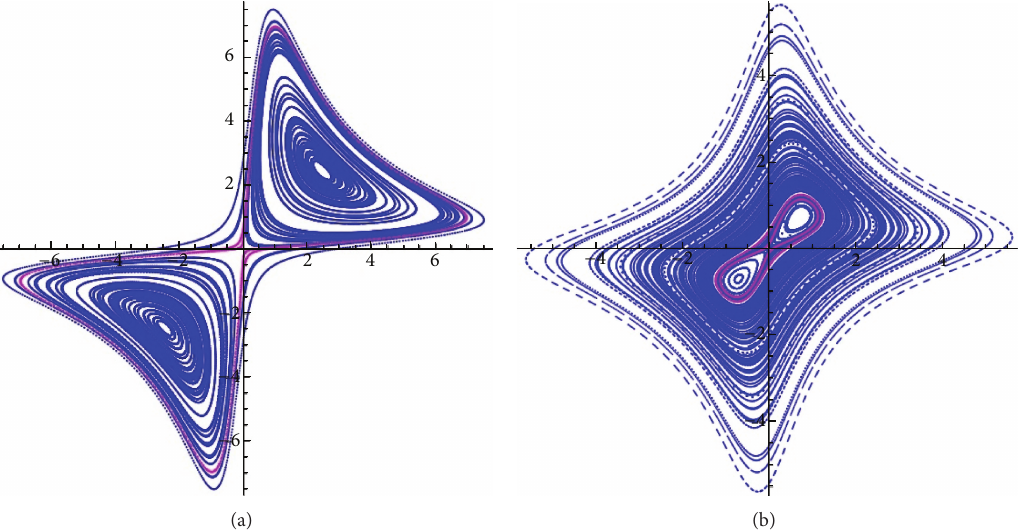
Figure 2: (a) A phase portrait of three orbits for 𝑎 = 1.5 . (b) A phase portrait of three orbits for 𝑎 = 7 . The plots are produced by Dynamica 3 [10].